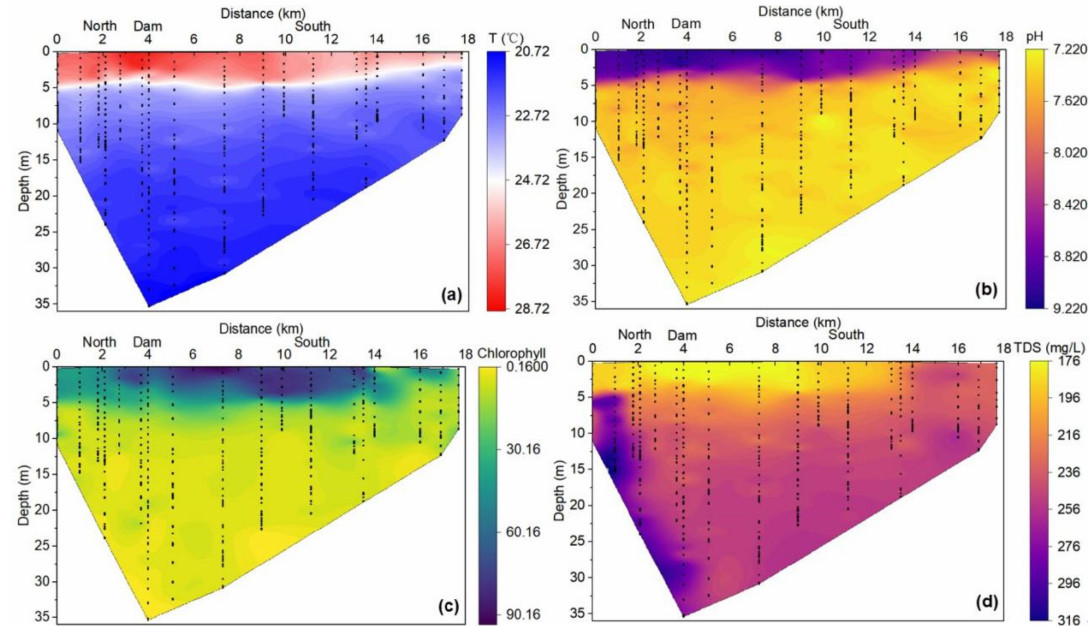
Figure 2. Hydrochemistry distribution in 24 profiles on 29 July 2019 (from Taoguayuan river outlet to Yangchang river outlet, which was 4 km and 14 km from the dam, respectively). ( a ) water T, ( b ) pH, ( c ) chlorophyll, and ( d )